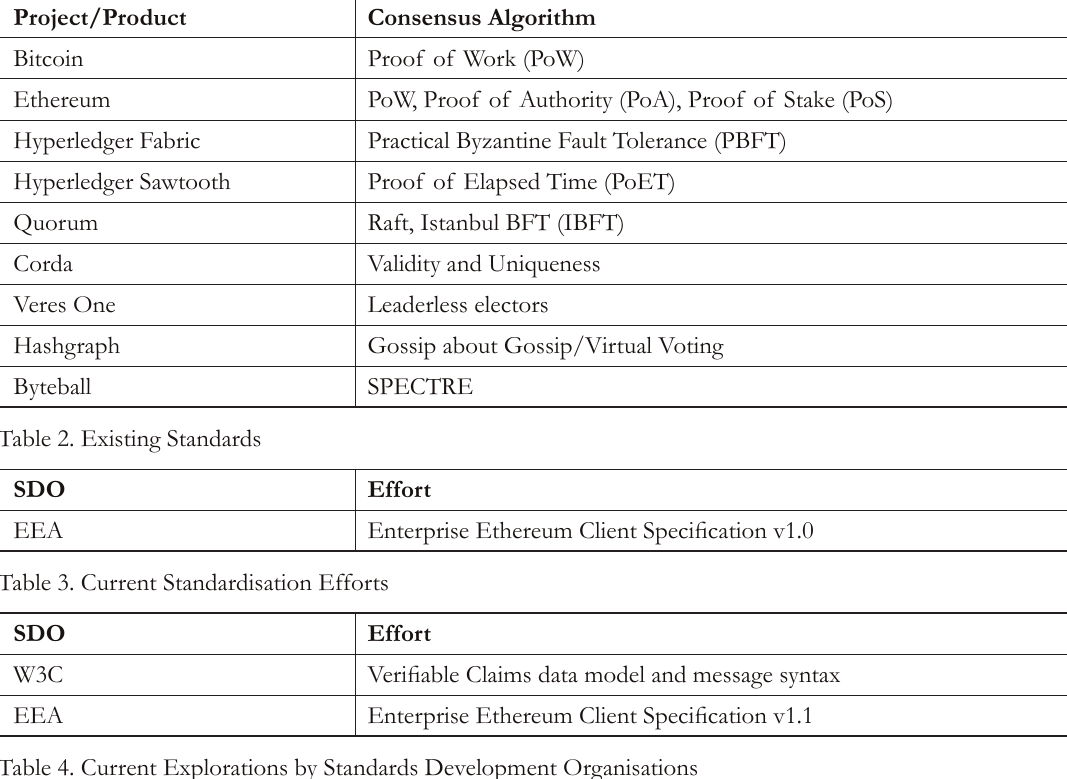
Table 1. Variations of “Blockchains” and their Consensus Algorithms